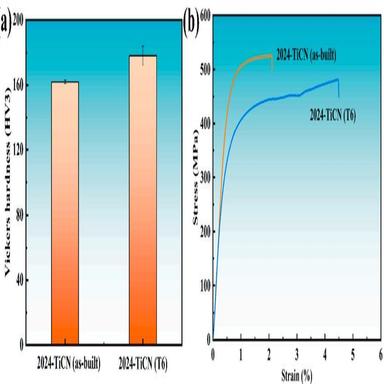
Mechanical properties of T6 heat treated vs. as-built 2024-5 vol% TiCN composites, (a) Vickers hardness, and (b) tensile stress-strain curves.